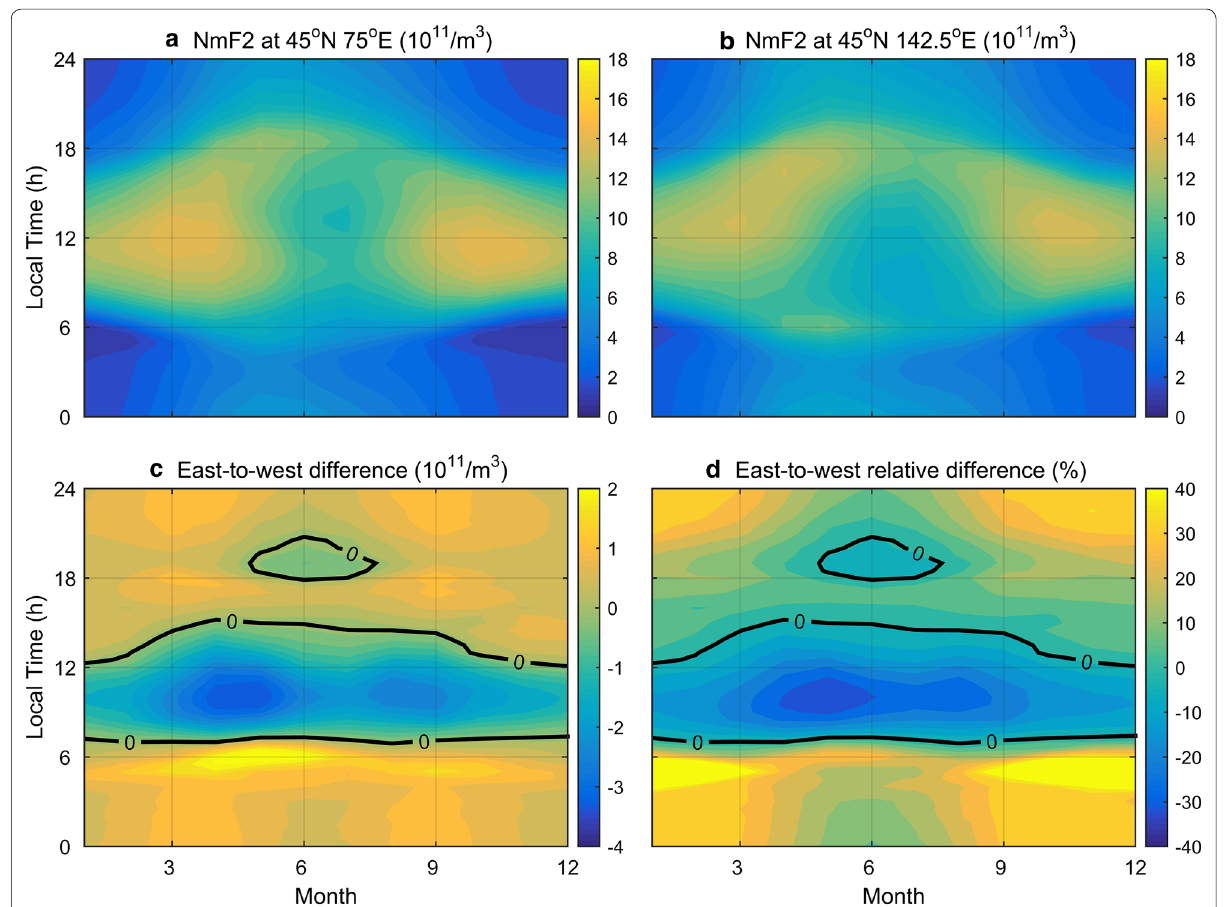
Fig. 2 Same as Fig. 1, but for case II, which removes the longitudinal variations of neutral